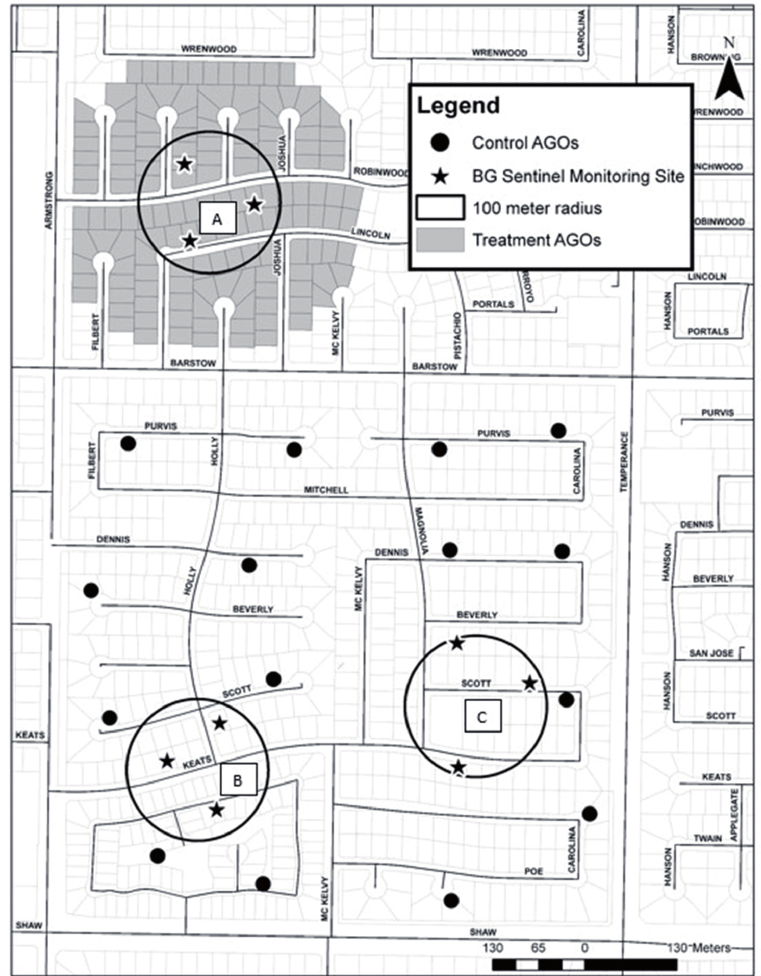
Figure 3. Map showing the layout and positions of AGO-B and BGS traps to evaluate the control efficacy of high density placement of AGO-B traps in residential Clovis. Properties shaded in grey were those that had an AGO-B trap placed in their front yard (144 traps in total). Stars represent locations of BGS traps used to measure abundance per week in both the control and intervention areas. Dark circles show positions of AGO-B traps outside the intervention area which were used for control site